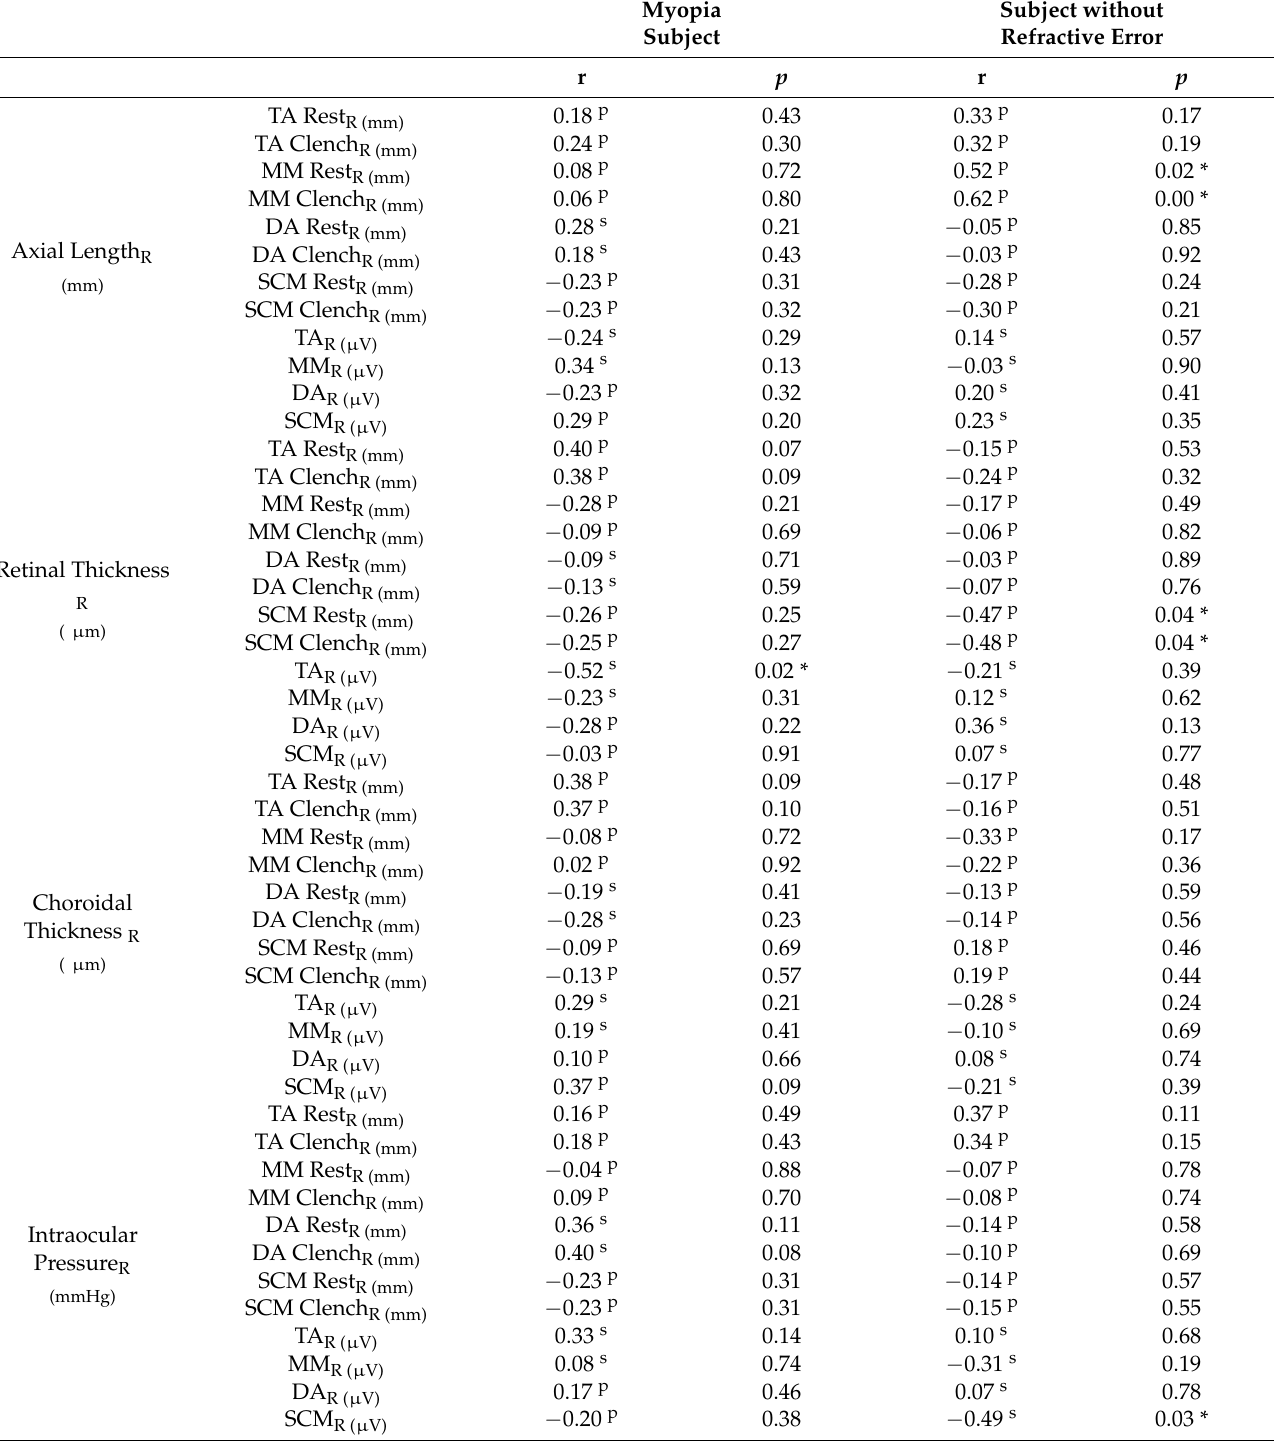
Table 3. Presentation of the resulting right-hand correlations between